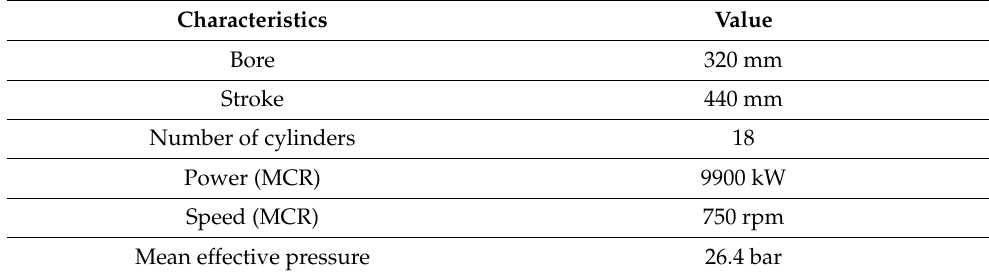
shaft, 3—gearbox, 4—four-stroke diesel engine).